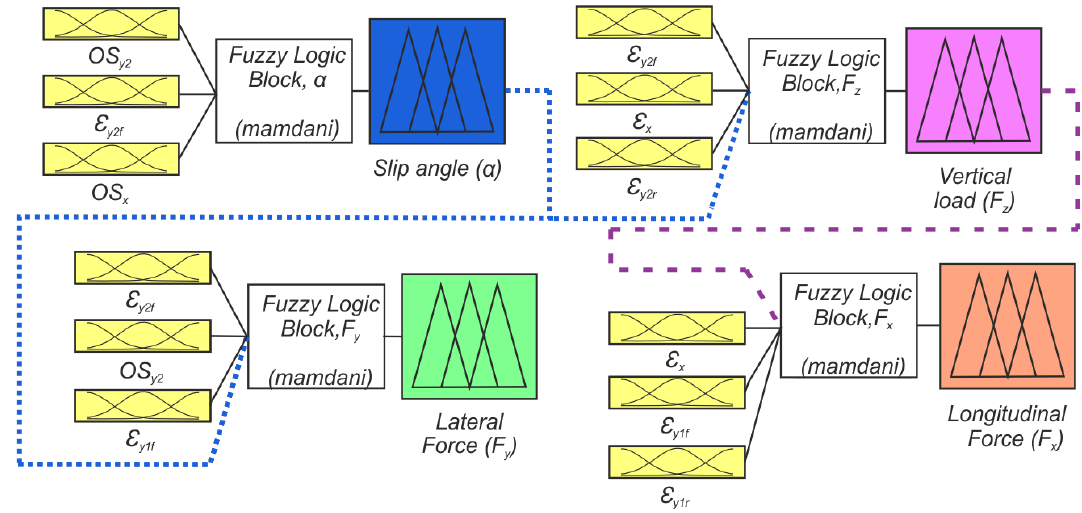
Figure 9. Architecture of the fuzzy logic system applied to develop the strain-based method.